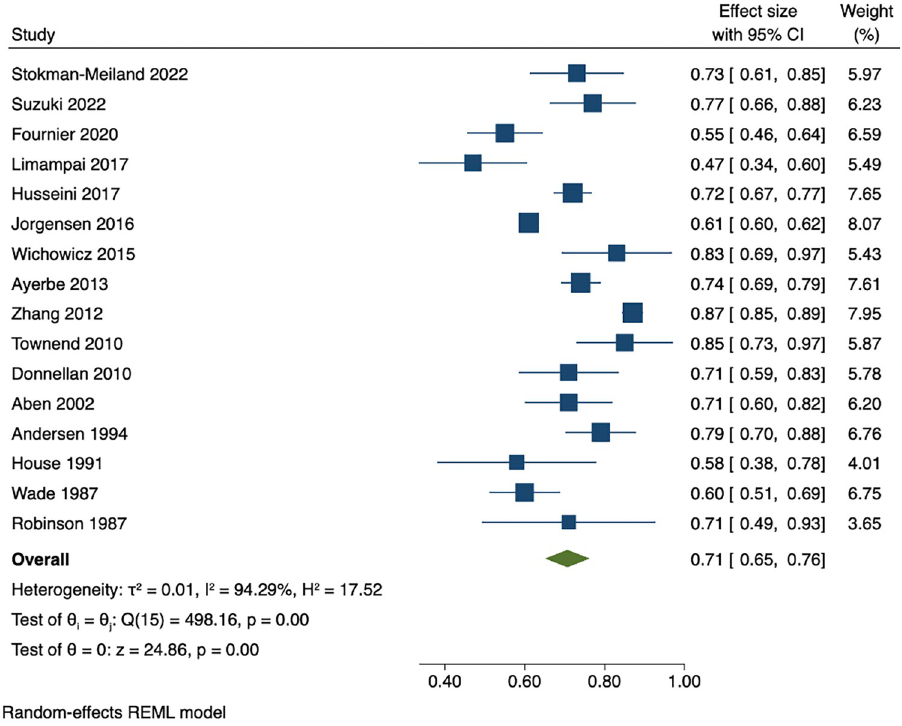
Fig 7. Proportion of early-onset depression (within 3 months after stroke) among all incident cases during 1 year after stroke.